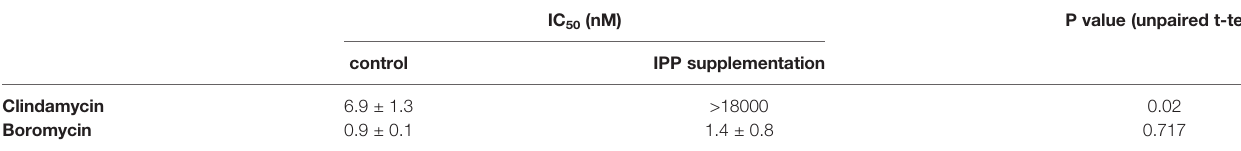
TABLE 4 | IC 50 values obtained with isopentenyl pyrophosphate trilithium salt (IPP) rescue assay in comparison to standard drug assays against P. falciparum strain 3D7.